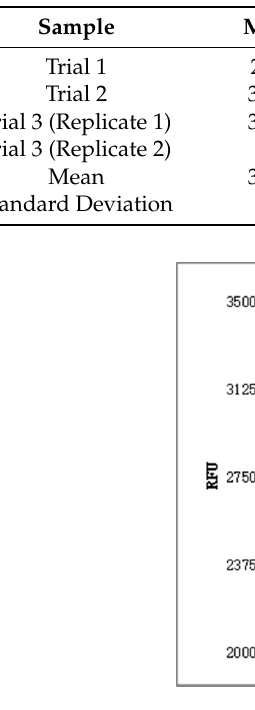
Figure 8. Amyloid aggregation assay results.